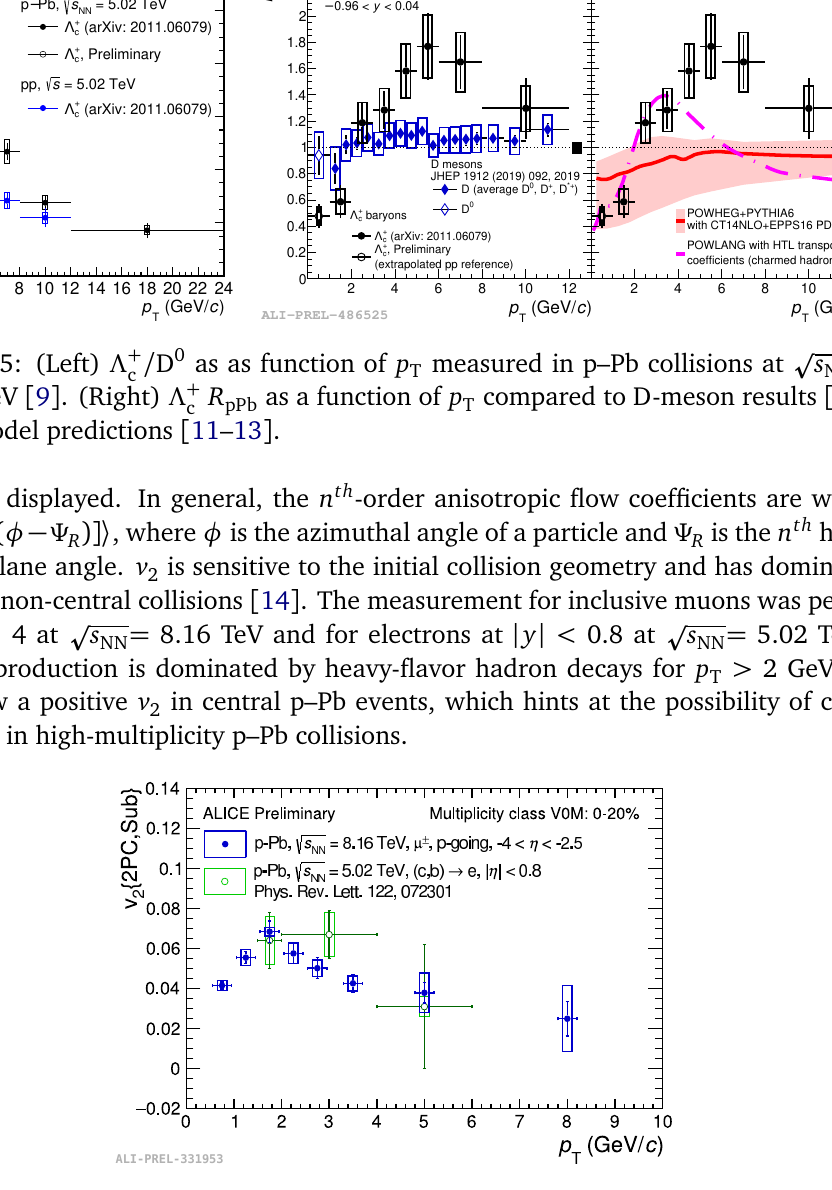
in p–Pb collisions at T